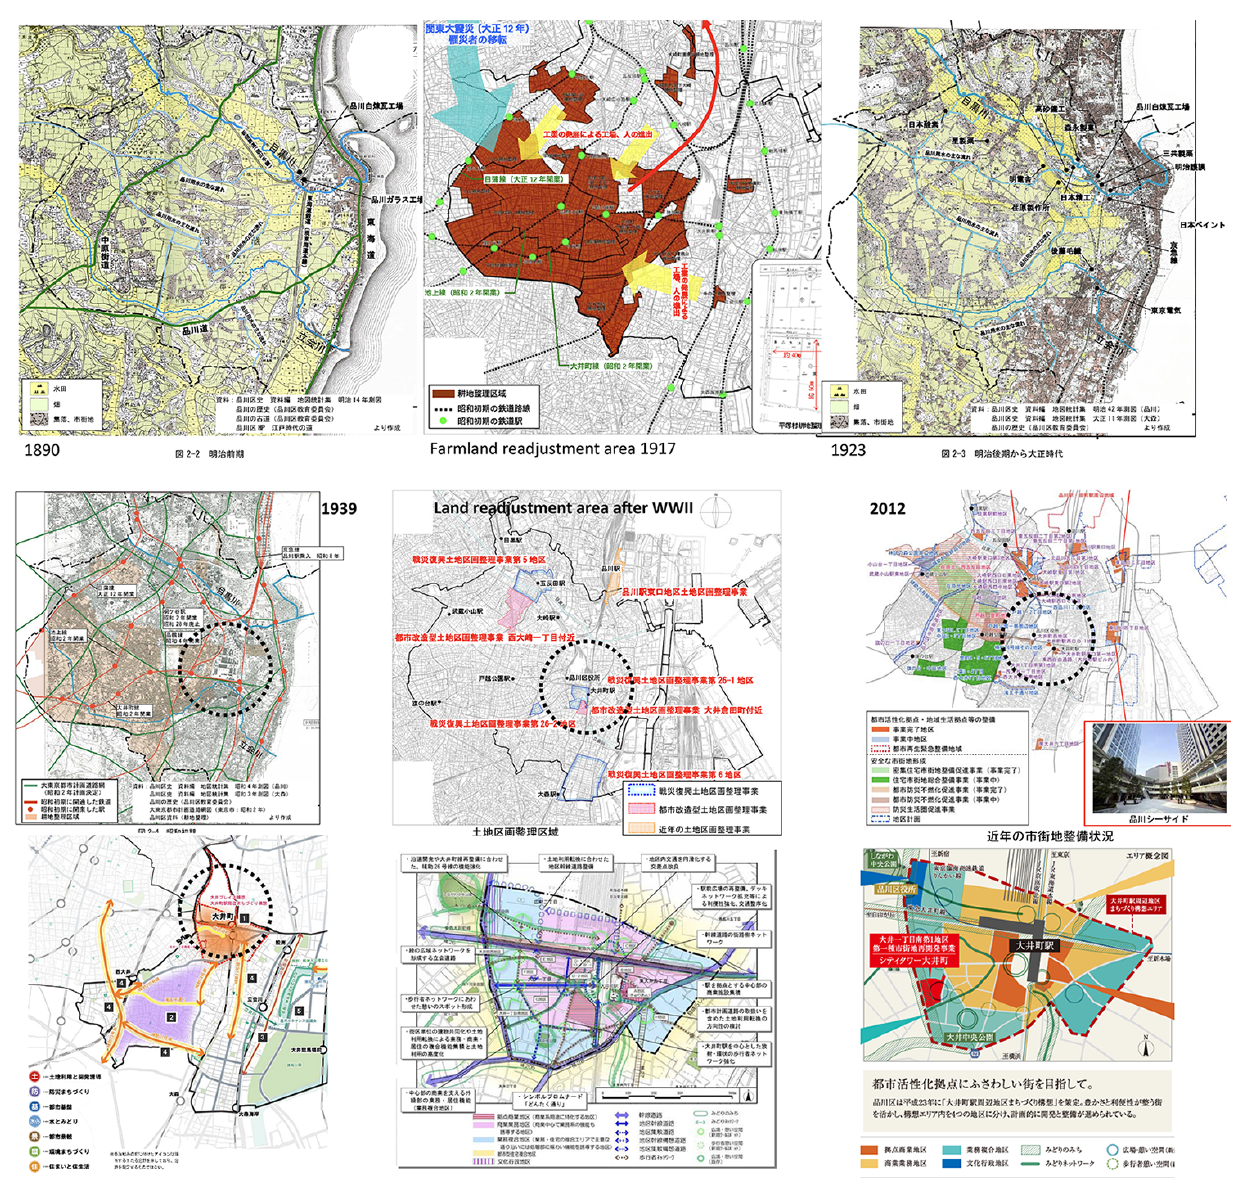
Figure 10. Period of change in the first decades of the 20st century: from a rural to an urban landscape (upper three maps) and permanent dynamic conditions around Oimachi station (lower six maps). Source: Courtesy of the City of